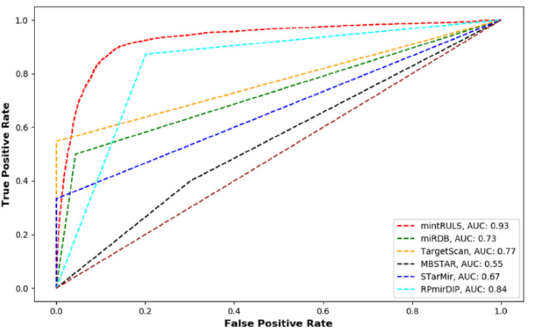
Figure 3. Performance comparisons between predictions made by mintRULS model and other previous methods that include miRDB, TargetScan, MBSTAR, RPmirDP, and STarMir, using Receiver operating characteristics (ROC) curve and Area Under Curve (AUC) determination. The dark red dashed diagonal line stands for a non-discriminatory test.